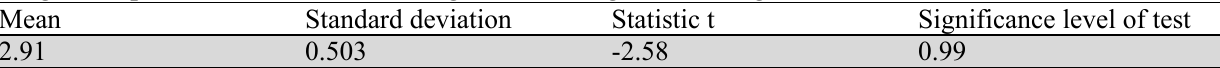
Single sample T test results to investigate achieving economic goals Mean